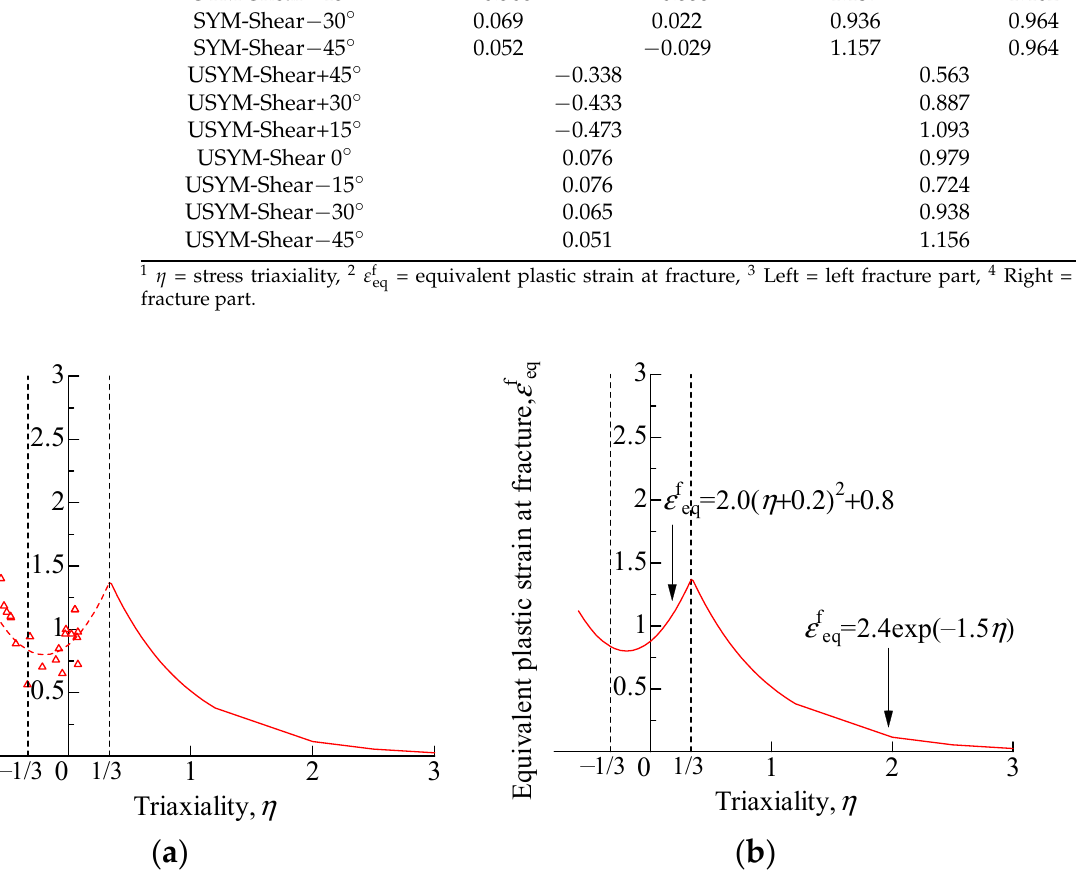
Figure 15. ( a ) Stress triaxiality vs. equivalent plastic strain obtained from the non-fracture analysis; ( b ) the modified N-VG model for fracture criteria of high-strength steel.